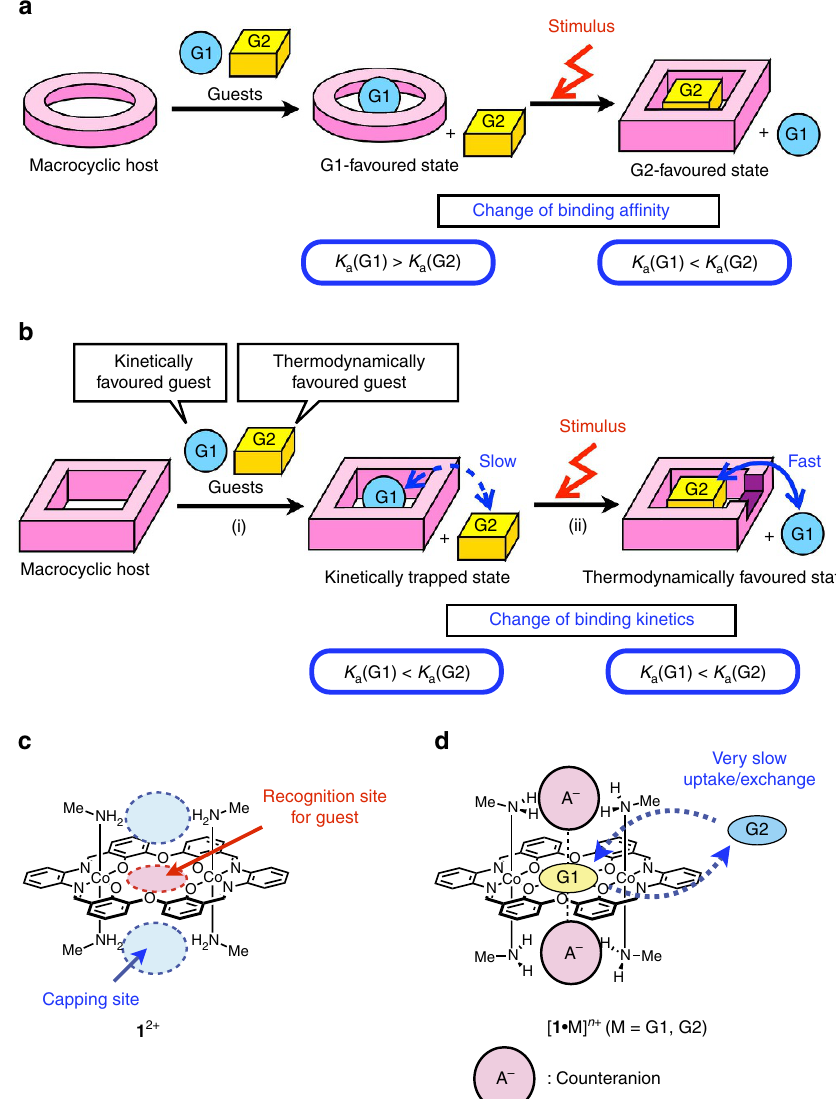
Figure 1 | Design and concept for kinetically controlled on-demand acceleration of guest uptake/exchange. ( a ) Schematic illustration of thermodynamically controlled stimuli-responsive guest exchange in which the association constants for two different of guests are reversed by an external stimulus. ( b ) Schematic illustration of kinetically controlled stimuli-responsive guest exchange in which the kinetic barrier for the guest exchange is removed by an external stimulus. ( c ) Design of macrocyclic host 1 2 þ with two capping sites. ( d ) Concept of the extremely slow guest uptake/exchange by taking advantage of anion